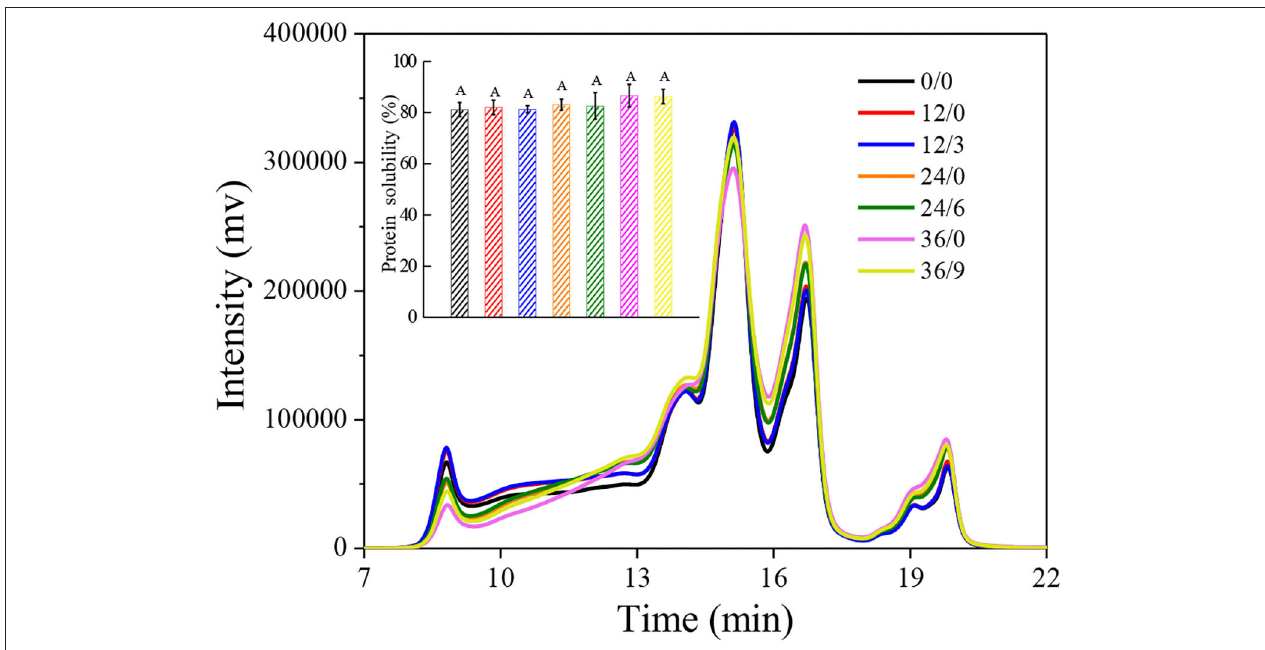
FIGURE 9 | Size exclusion-HPLC chromatograms of whole wheat flour during germination under UV-B radiation. The inset shows protein solubility of wheat. Letter in the inset indicates the results of Duncan’s multiple range test at 5% level of significant difference among different germination and UV-B radiation time,